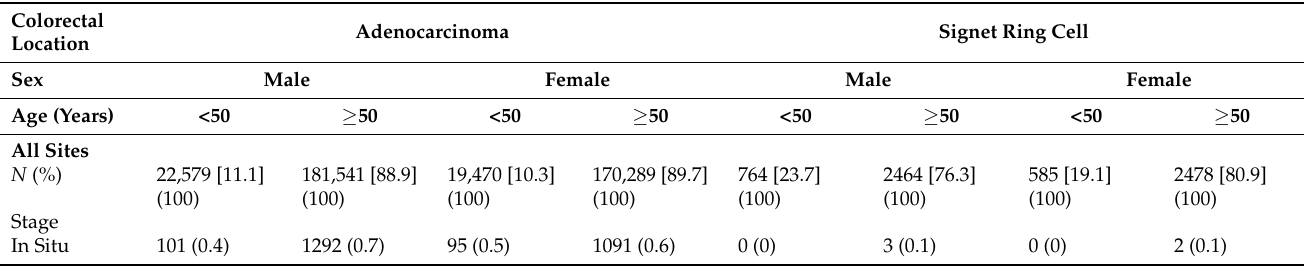
Table 5. Distribution of colorectal cancer by localization, dichotomized by sex, and age